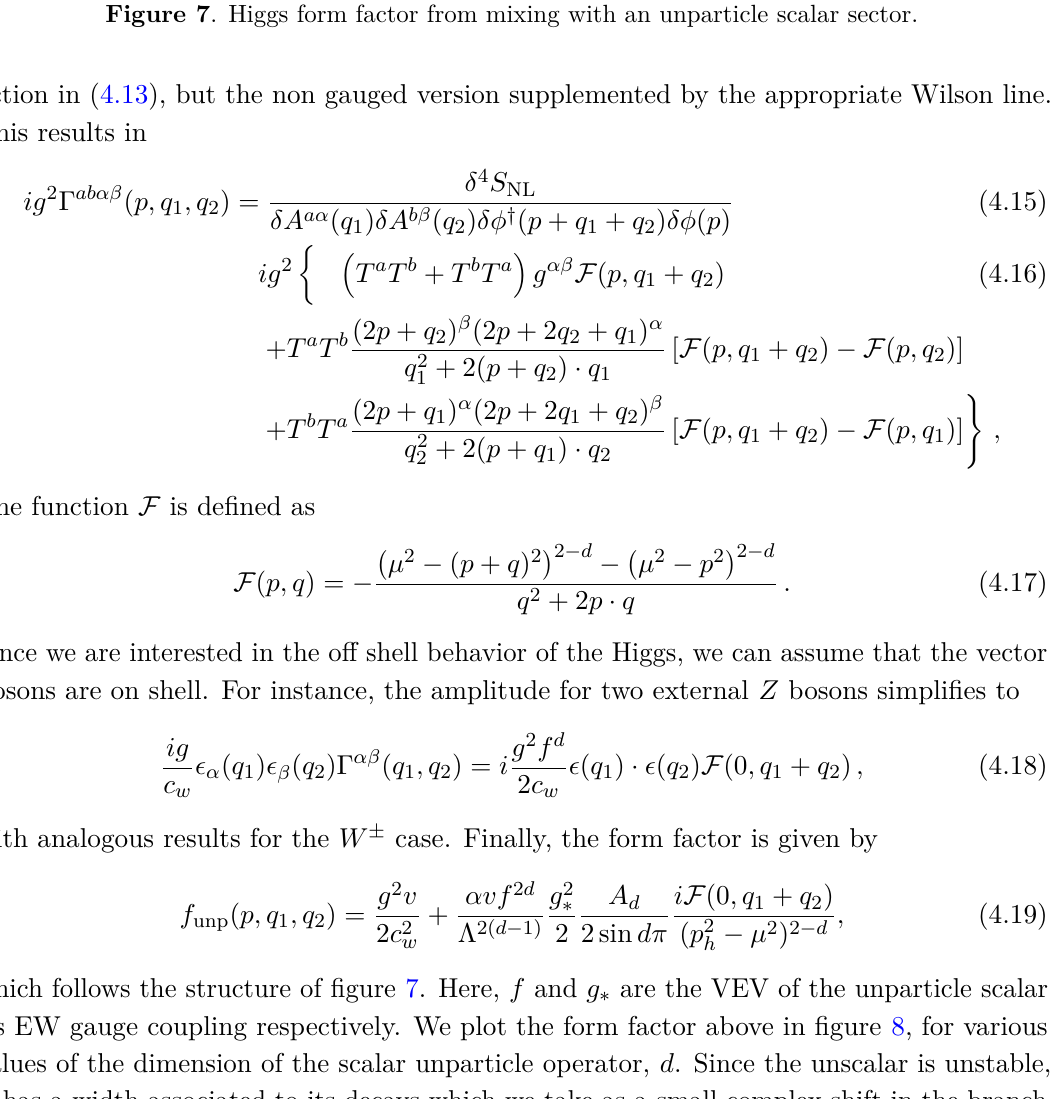
Figure 7 . Higgs form factor from mixing with an unparticle scalar